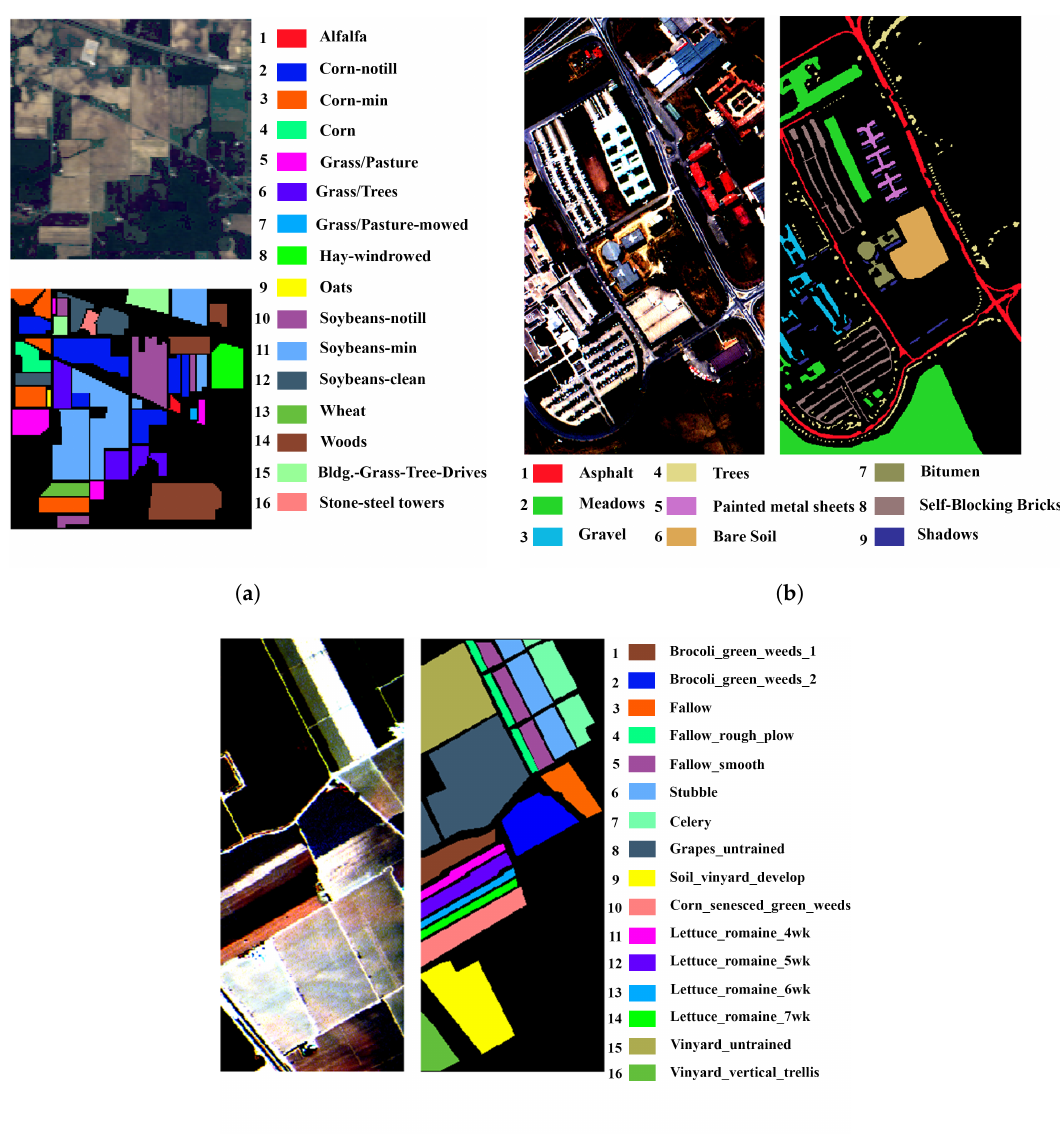
Figure 4. The false color composite and the ground truth map of the experiments data: ( a ) Indiana, ( b ) PaviaU, and ( c )